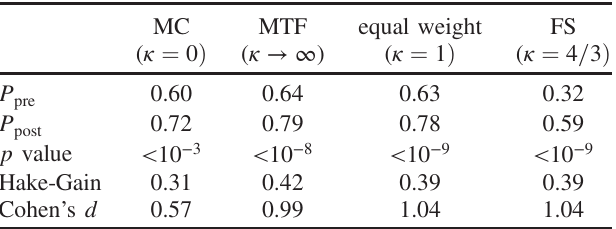
TABLE V. Matched sample ( N ¼ 44 ) pre- and poststatistics for test components and total test scores (FS ¼ Formula scoring).